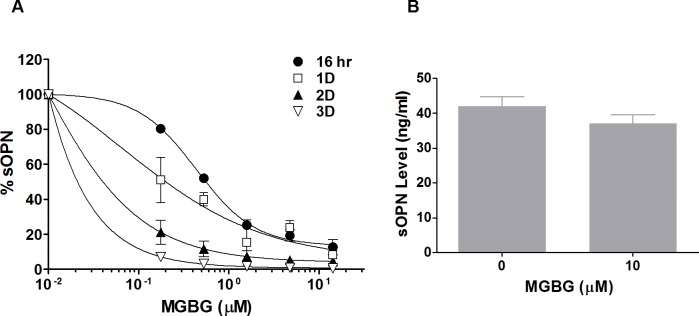
MGBG potently inhibited sOPN production in monocytes, but showed limited inhibitory effect in differentiated macrophages.(A). MGBG significantly inhibited sOPN production in monocytes. The degree of MGBG inhibition on sOPN was related to time of exposure. Isolated human monocytes were cultured at 0.1 million cells per ml with various concentrations of MGBG for 16 hr, 1, 2 and 3 days. MGBG showed potent inhibition on monocyte sOPN production with IC50 < 0.1 μM on day 3. Data were presented as percentage of untreated controls. The average sOPN levels of untreated monocytes were approximately 110, 130, 670 and 5300 pg/ml at 16 hr, 1, 2, and 3 days, respectively. The inhibition is independent of cytotoxicity (e.g. little cell death at 16 hours and day 1). The data is normalized to number of live cells in the culture. n = 2. (B). MGBG showed limited inhibitory effect on sOPN production in mature macrophages. Isolated monocytes were cultured to allowed to differentiate into macrophages for 6 days prior to drug treatment. Fresh media was replaced and cells were treated with 10 μM MGBG for 3 days. n = 4, means and SEM.